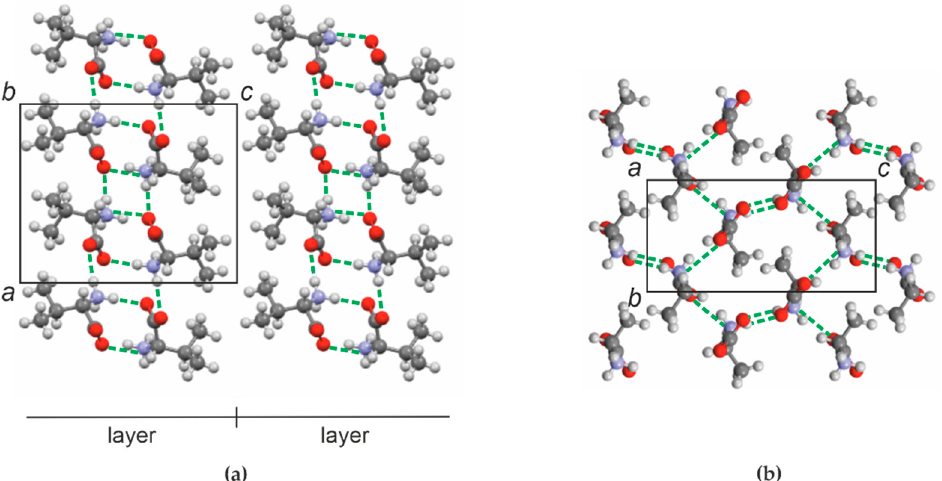
Figure 11. Projection of the L-valine crystal structure onto the ac plane of the monoclinic cell [18] ( a ) and projection of the L-alanine crystal structure onto the bc plane of the orthorhombic cell ( b ). Dotted lines are hydrogen bonds. The projections of the orthorhombic cell are plotted using the structural data from CSD (identifiers LVALIN01 and LALANINE54 [35]).